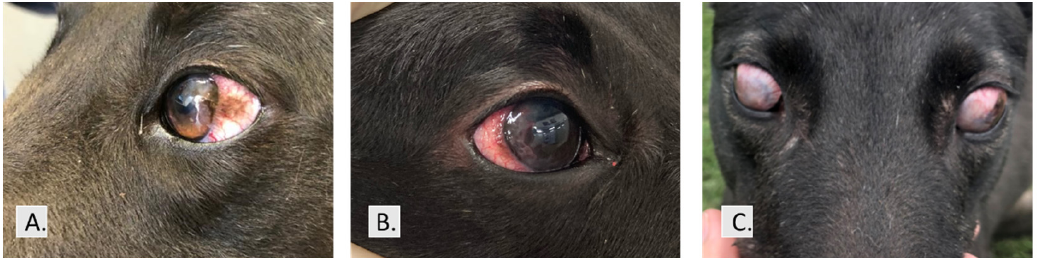
Figure 1. Ocular changes observed in Chronic Superficial Keratitis. ( A ) Early stages: raised, pig- mented, and vascularized lesions commence development in the anterior corneal stroma. ( B ) Inter- mediate stage: vascularized regions advance with the disease progression. ( C ) Severe stage: granular tissue may eventually cover the cornea and the entire ocular surface.